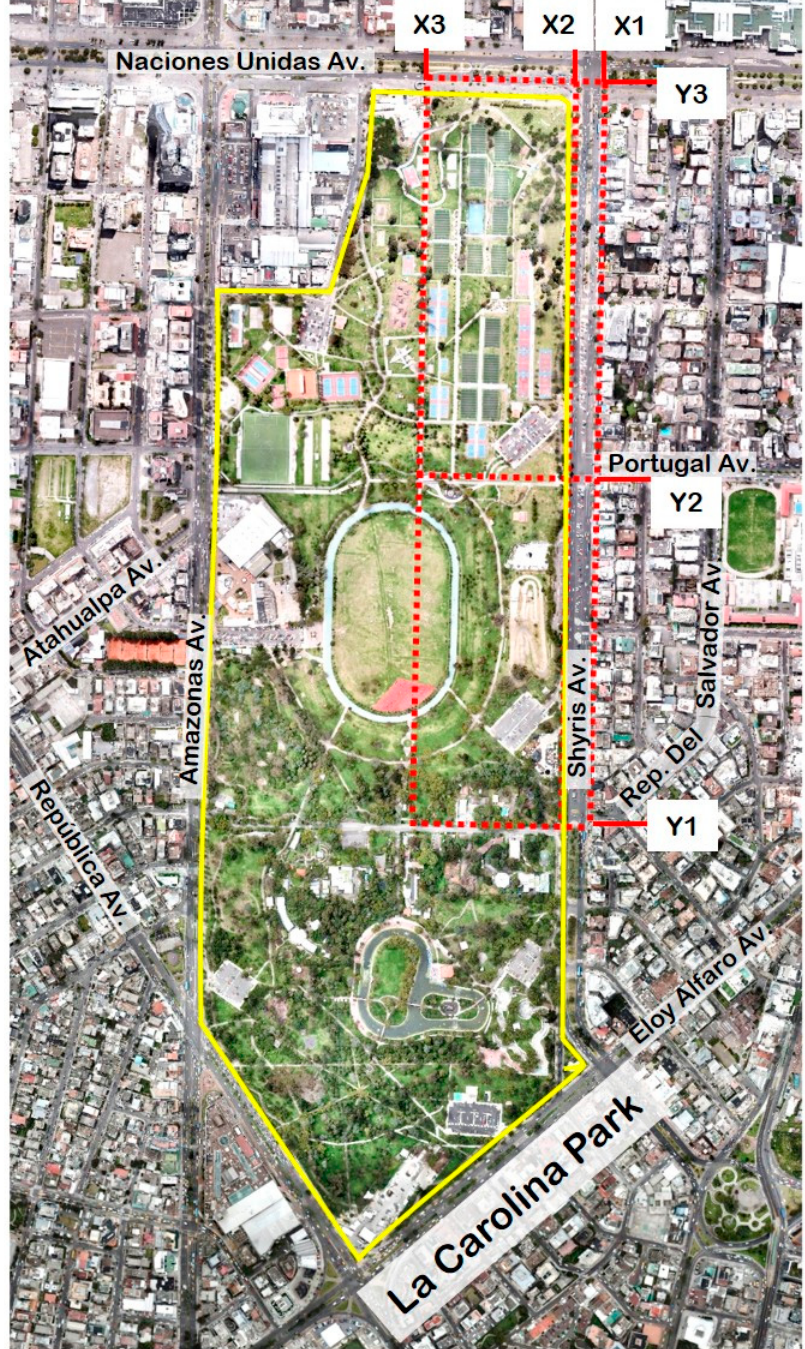
Figure 1. Park and route that was followed to perform the measurements. Urban park: Space delimited by the yellow lines; Route: Red dashed lines. (This figure has been taken from [13]).